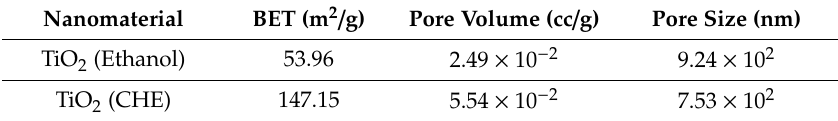
Figure 6. UV-vis diffuse reflectance spectra of the as synthesized TiO 2 nanomaterials ( a ), N 2 Figure 6. UV-vis di ff use reflectance spectra of the as synthesized TiO 2 nanomaterials ( a ), adsorption-desorption isotherms of the as synthesized nanomaterials ( b ). N 2 adsorption-desorption isotherms of the as synthesized nanomaterials ( b ). Table 1. The surface area and the porous parameters of the as prepared